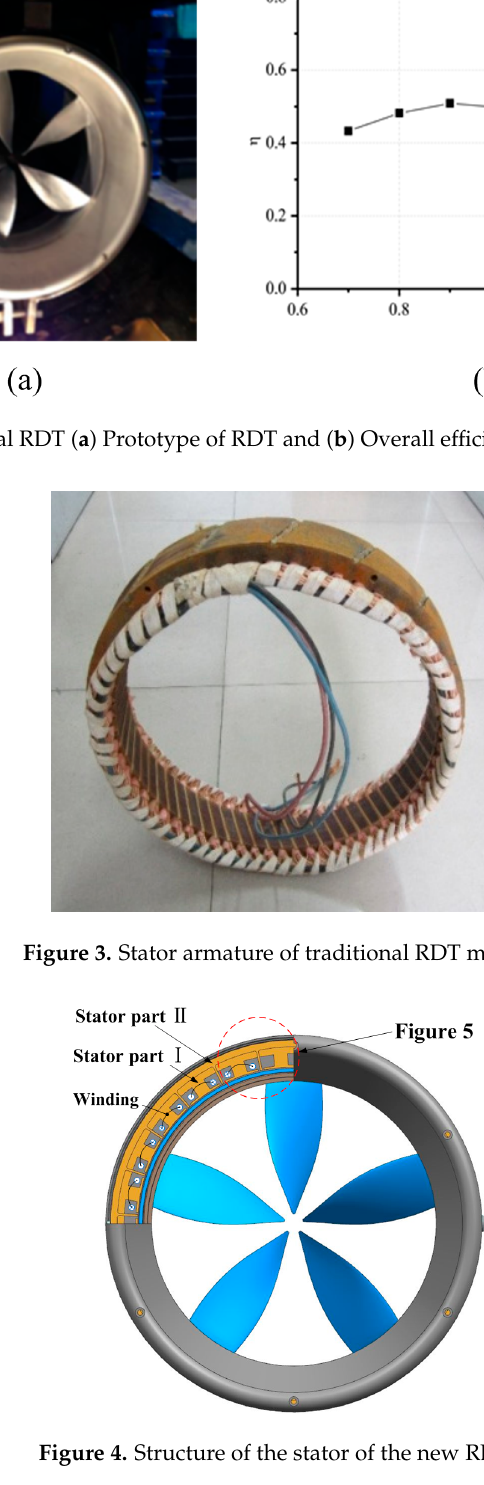
Figure 4. Structure of the stator of the new RDT.